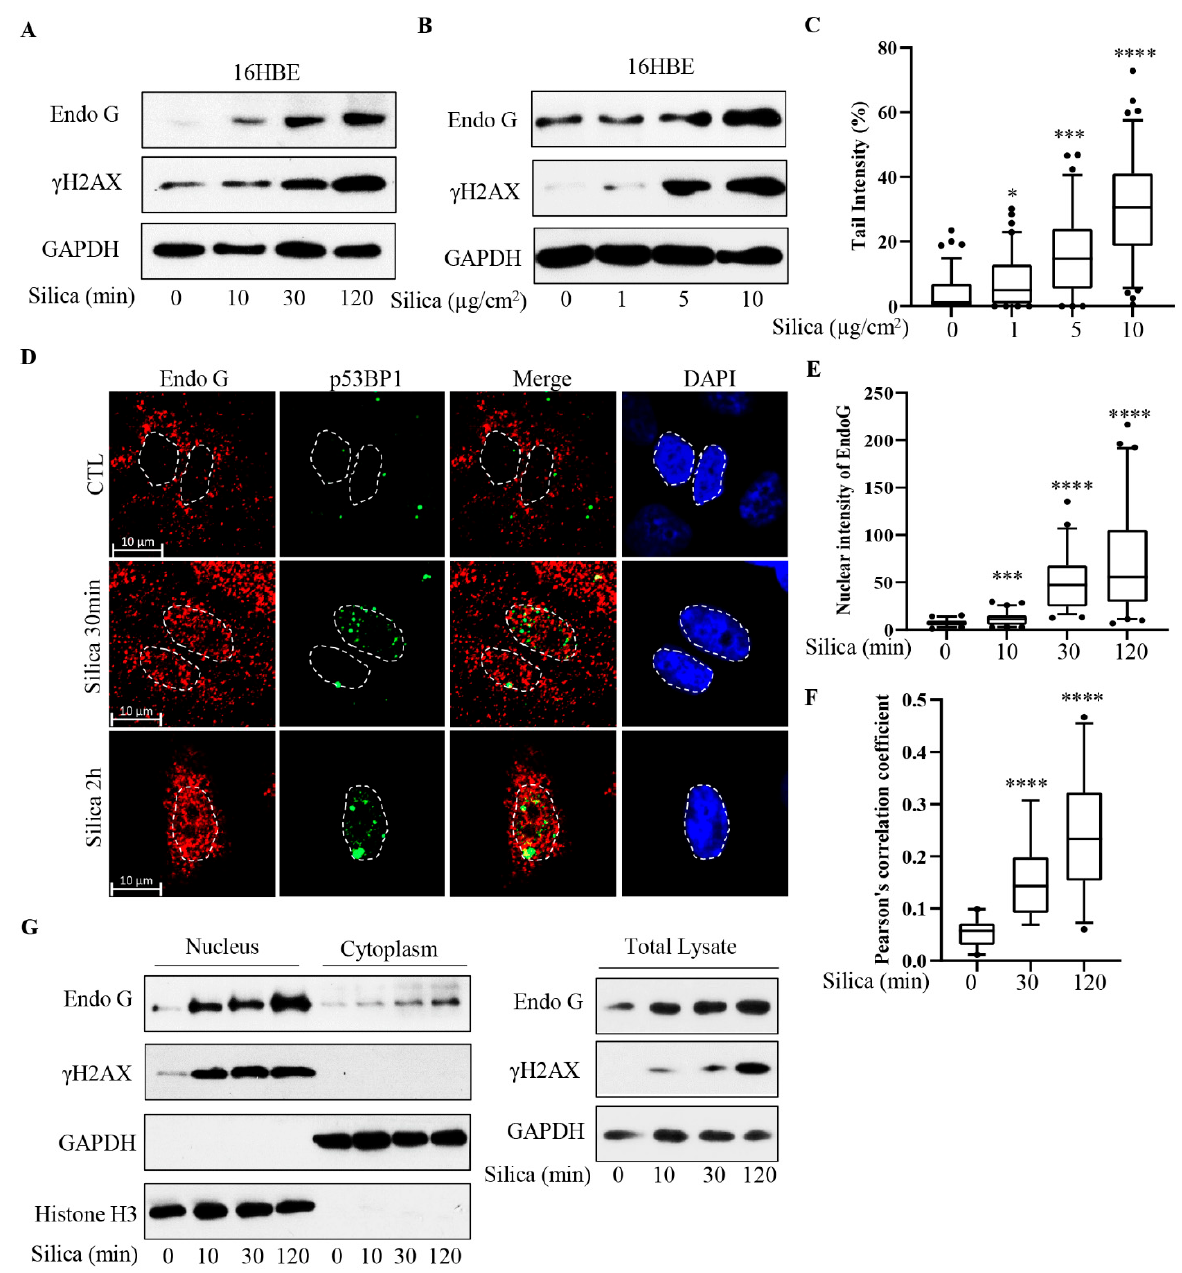
Figure 1. Silica-induced translocation of EndoG in respiratory epithelial cells in vitro. In ( A ), 16HBE cells were exposed to silica (5 µ g/cm 2 ) for times indicated. Cell lysates were analyzed for γ H2AX and EndoG by Western blotting. In ( B , C ), 16HBE cells were exposed to silica (1, 5, 10 µ g/cm 2 ) for 2 h. EndoG and γ H2AX were analyzed by Western blotting ( B ) and DNA damage was analyzed by Comet assay ( C ). In ( D ), representative confocal images showing EndoG (red), p53BP1 (green) and nuclear (blue) staining in 16HBE cells exposed to silica (5 µ g/cm 2 ) for 30 min and 2 h. In ( E ), nuclear intensity of EndoG was quantified by using ImageJ software. In ( F ) EndoG and p53BP1 colocalization was quantified by Pearson’s correlation coefficient using Imaris software. In ( G ), cells were exposed to silica (5 µ g/cm 2 ) for times indicated and then subjected to nuclear extraction. EndoG and γ H2AX levels in nucleus were analyzed by Western blotting. Bars show median with 95% confidence interval. All experiments were performed at least in triplicate. * p < 0.05, *** p < 0.001, **** p < 0.0001, compared to control (CTL) as determined by ANOVA.